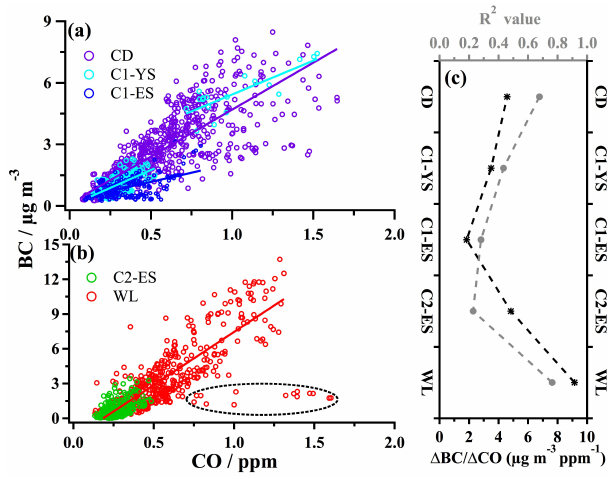
Figure 4. Scatter plots of BC vs. CO (a, b) and their regression slopes and correlation coefficients (c)